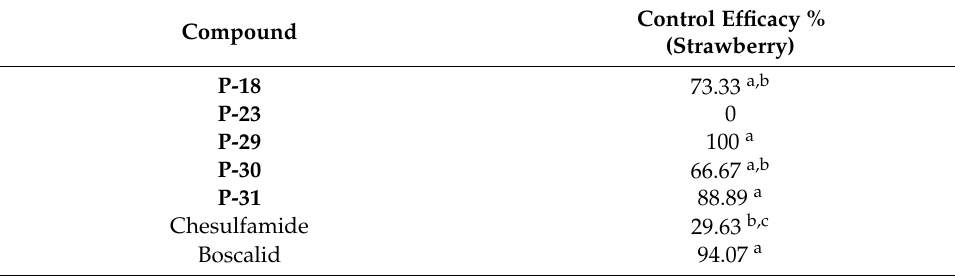
Table 4. Control efficacy of some compounds in strawberry test at 400